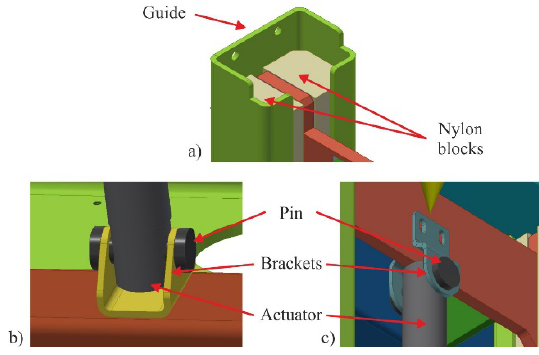
Figure 14. Identification of components that have a sliding/no penetration type contact (a), actuator (bottom end)/bracket (b) and actuator (upper end)/bracket